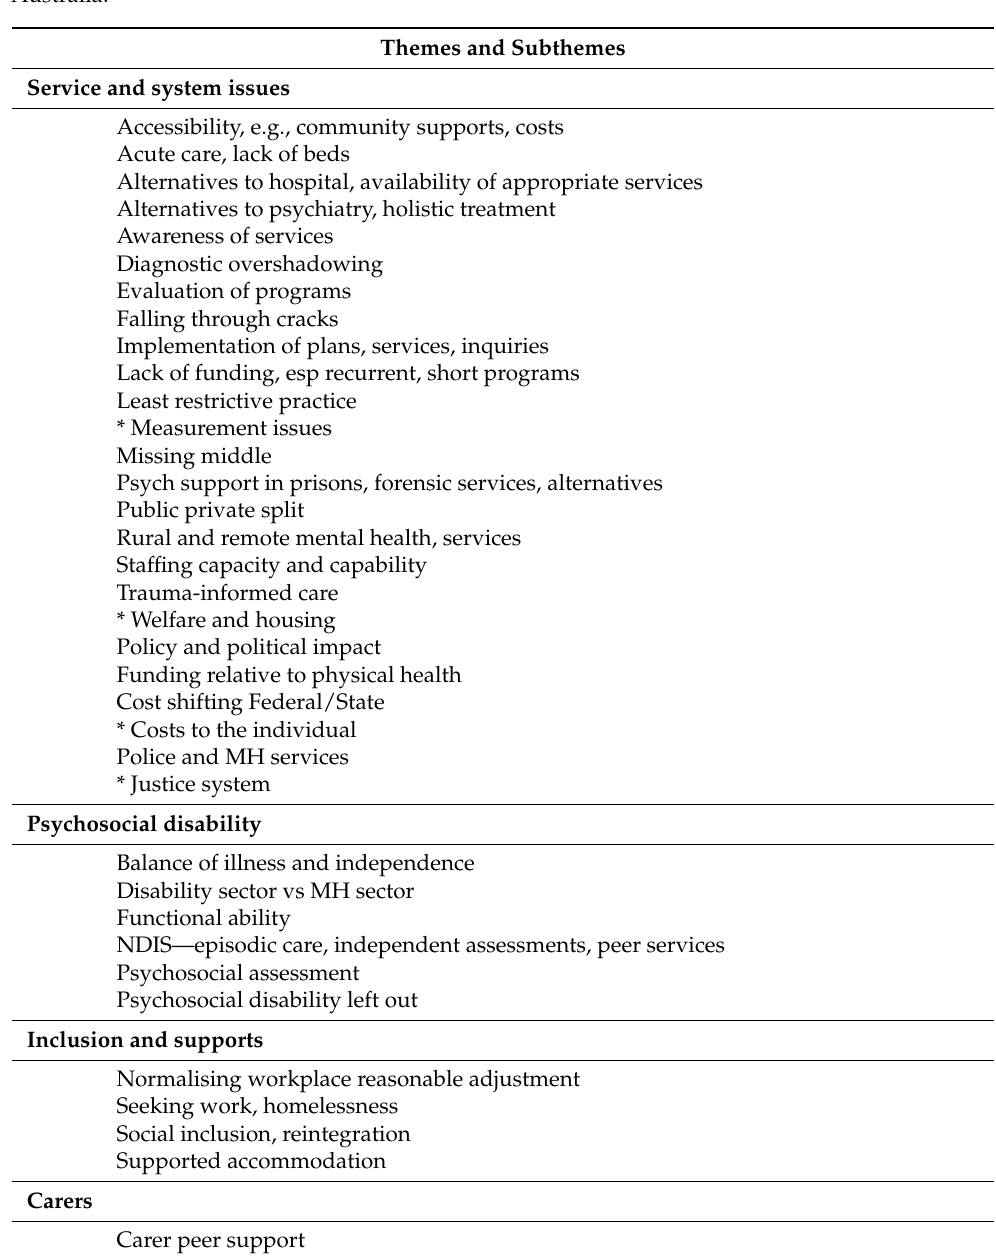
Table 1. Coded themes for questions (1) main issues, and (2) research priorities for mental health in